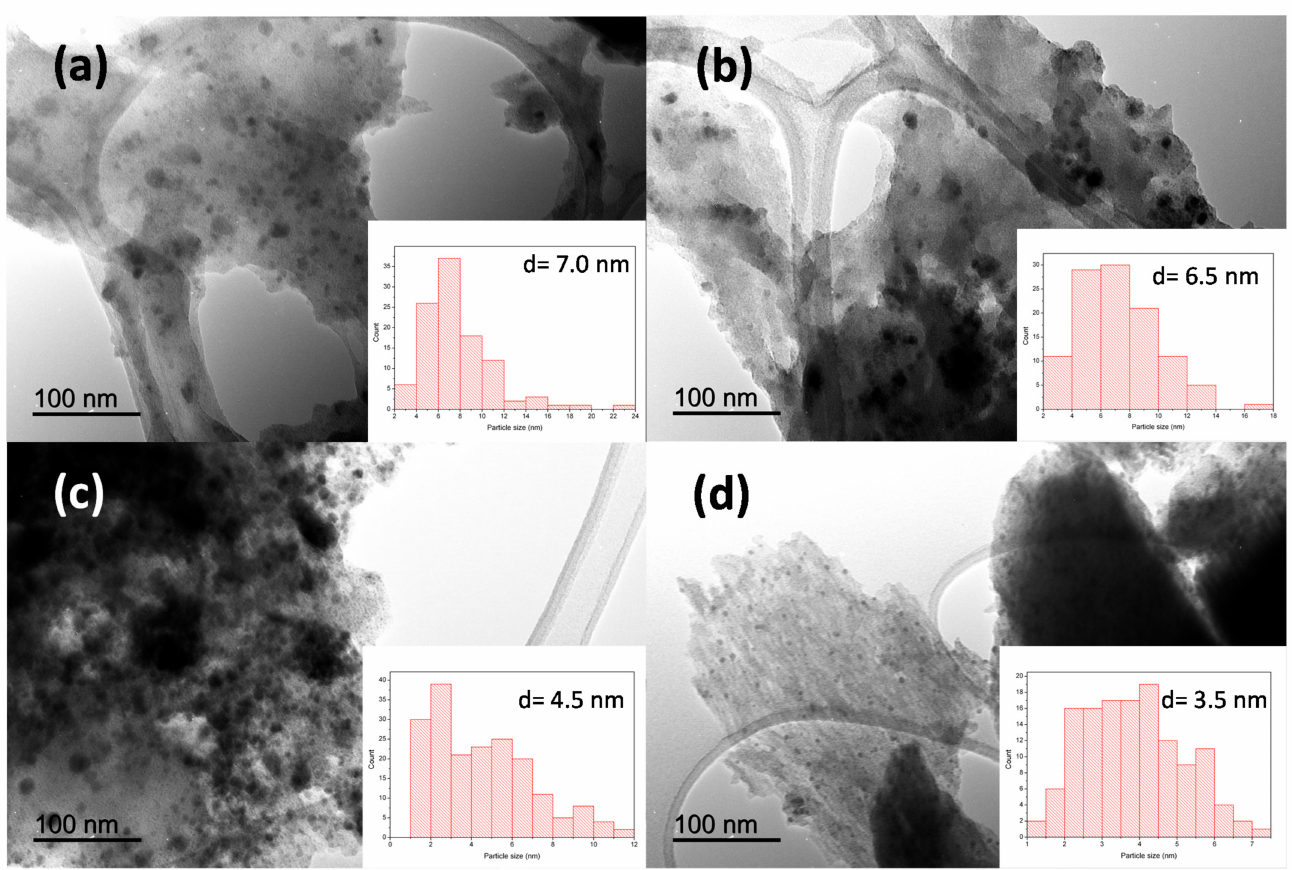
Figure 3. Transmission electron microscopy (TEM) images of ( a ) Cu-Fe@OP100 ◦ C, ( b ) Cu-Fe@OP200 ◦ C, ( c ) Cu-Fe@OP300 ◦ C, and ( d ) Cu-Fe@OP400 ◦ C samples. Inset shows the particles size histogram and the average particles size